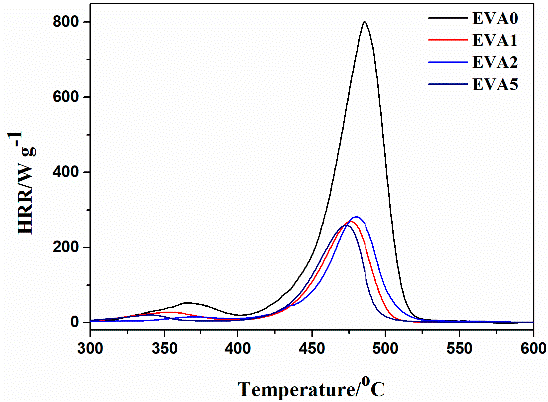
Figure 3. MCC curves of neat EVA and the EVA composites.